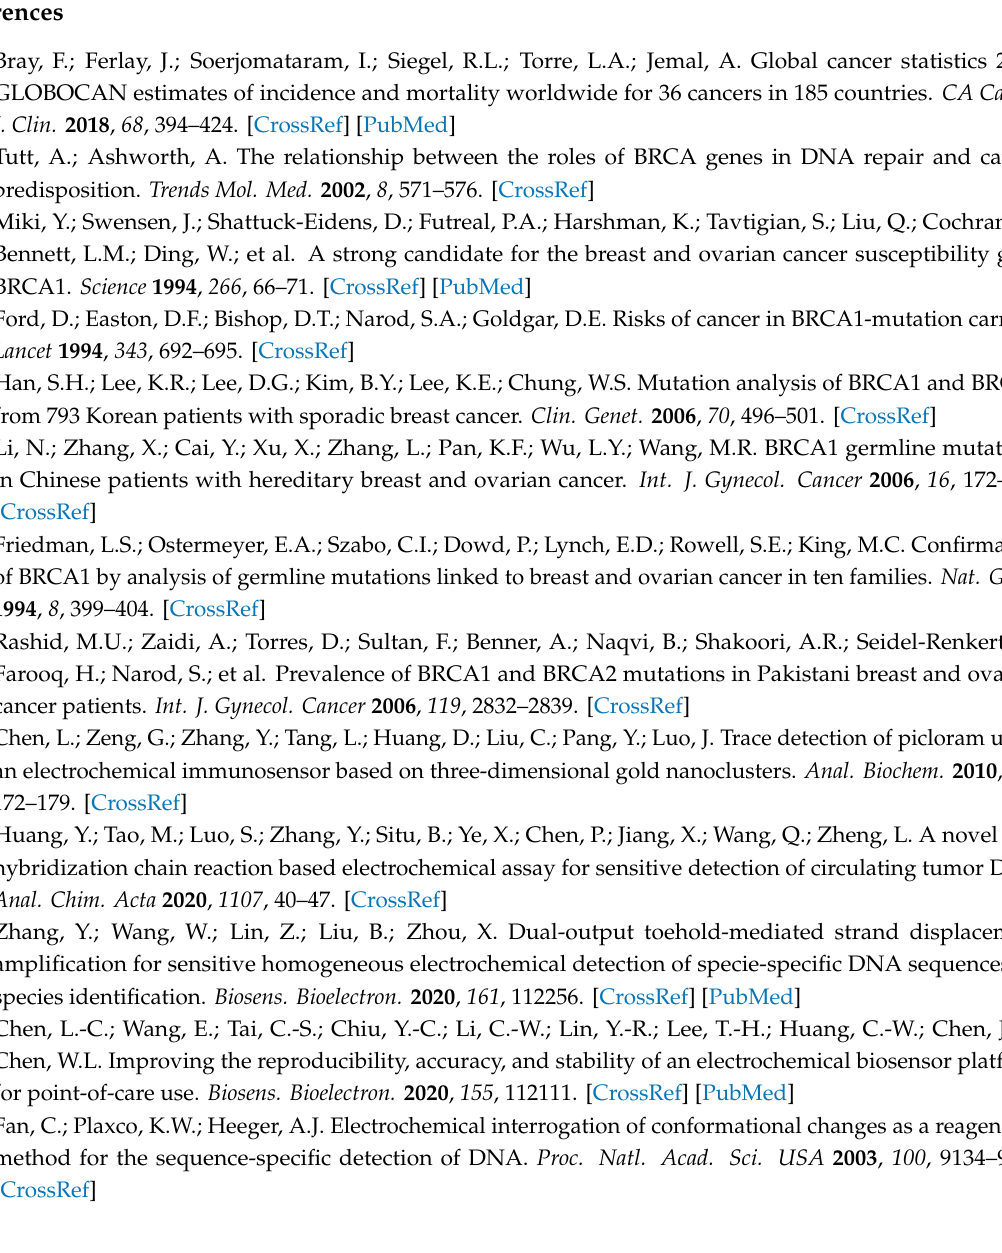
Figure S1: Characterization of the AuNPs-DNA-r; Table S1. Sequences used in the